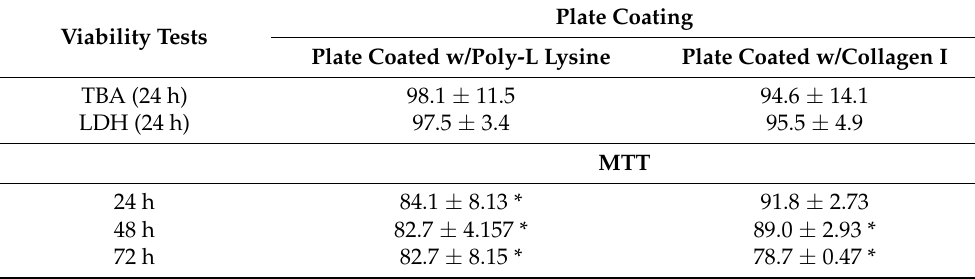
Figure 3. Culture of S. aurata primary hepatocytes isolated by pancreatin digestion with modifications ( A ) and after incubation in poly-L lysine-coated plates up to 24 ( B ), 48 ( C ), and 72 h ( D ). The observations were made under inverted light microscopy (Olympus) with a 10 × objective ( A , B ) and a 20 × objective ( C , D ). Table 2. The viability of primary hepatocytes isolated by pancreatin digestion after T 24 , T 48 , and T 72 in culture with different plates, no-treatment, and coated with the poly-L-lysine solution (Sigma) and collagen I (Sigma). Cell viability was evaluated by trypan blue assay (TBA) and MTT. All the data are expressed as % of T 0 and are expressed as the mean ± SD of more than 3 independent isolations. Significant differences from the T 0 was observed for the plates coated; * p <